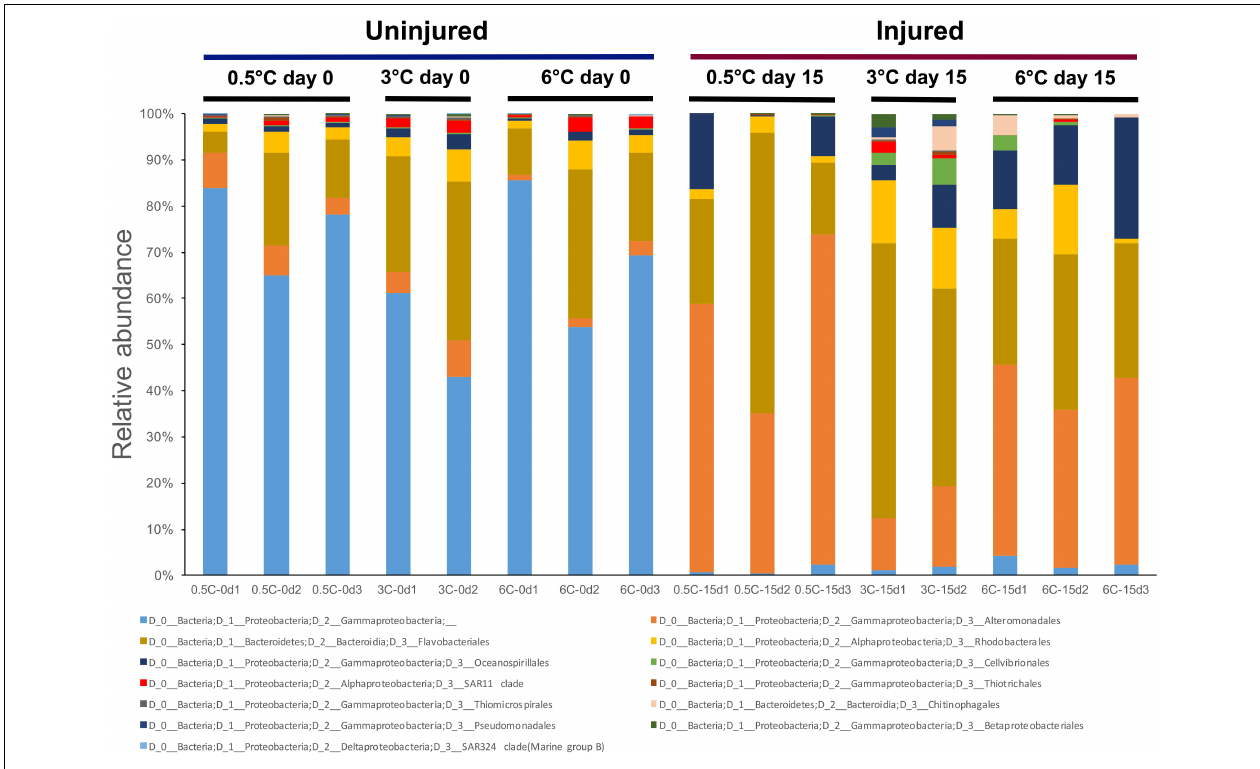
FIGURE 4 | Relative abundance of prokaryotic groups at the order level for Isodictya kerguelenensis individuals exposed to increased temperature and physical injuries.